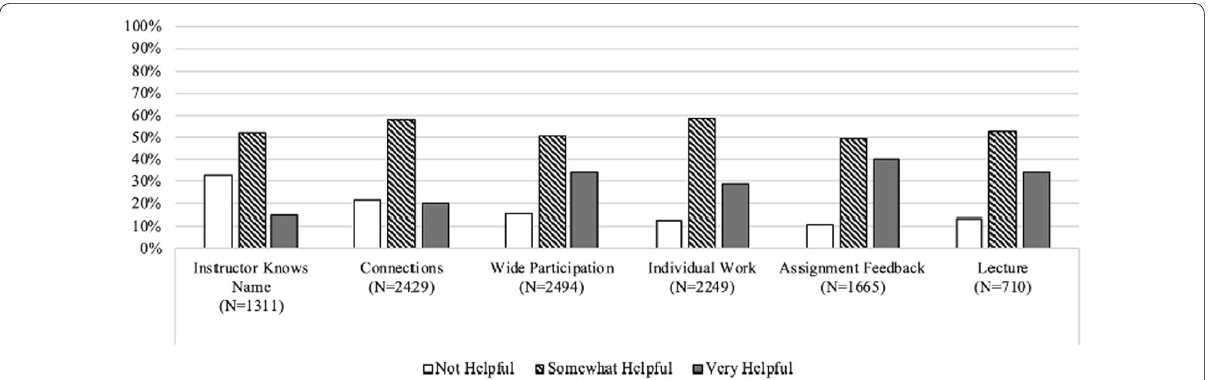
Fig. 8 Summary of helpfulness of minimally or somewhat descriptive Other Classroom Characteristics